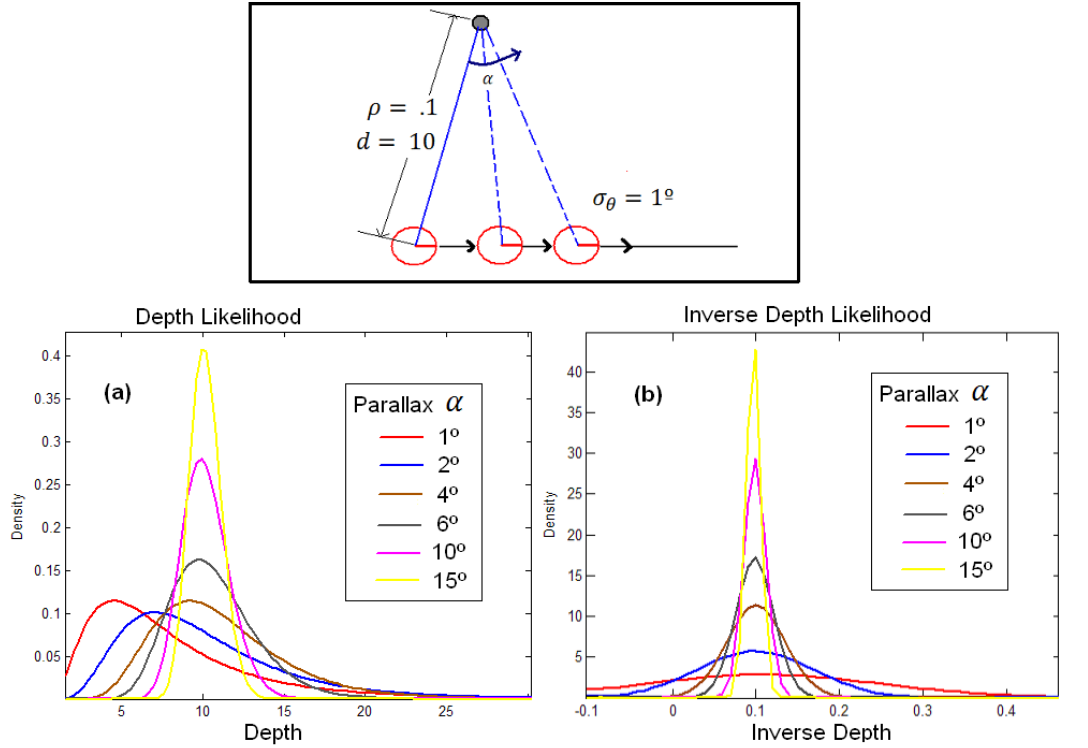
Figure 2. Simulation of a point reconstruction from observations with different